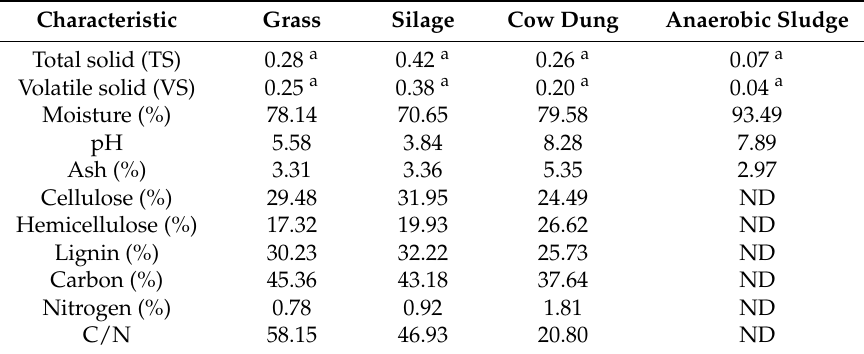
Table 7. Characteristics of grass, silage, cow dung, and anaerobic sludge.